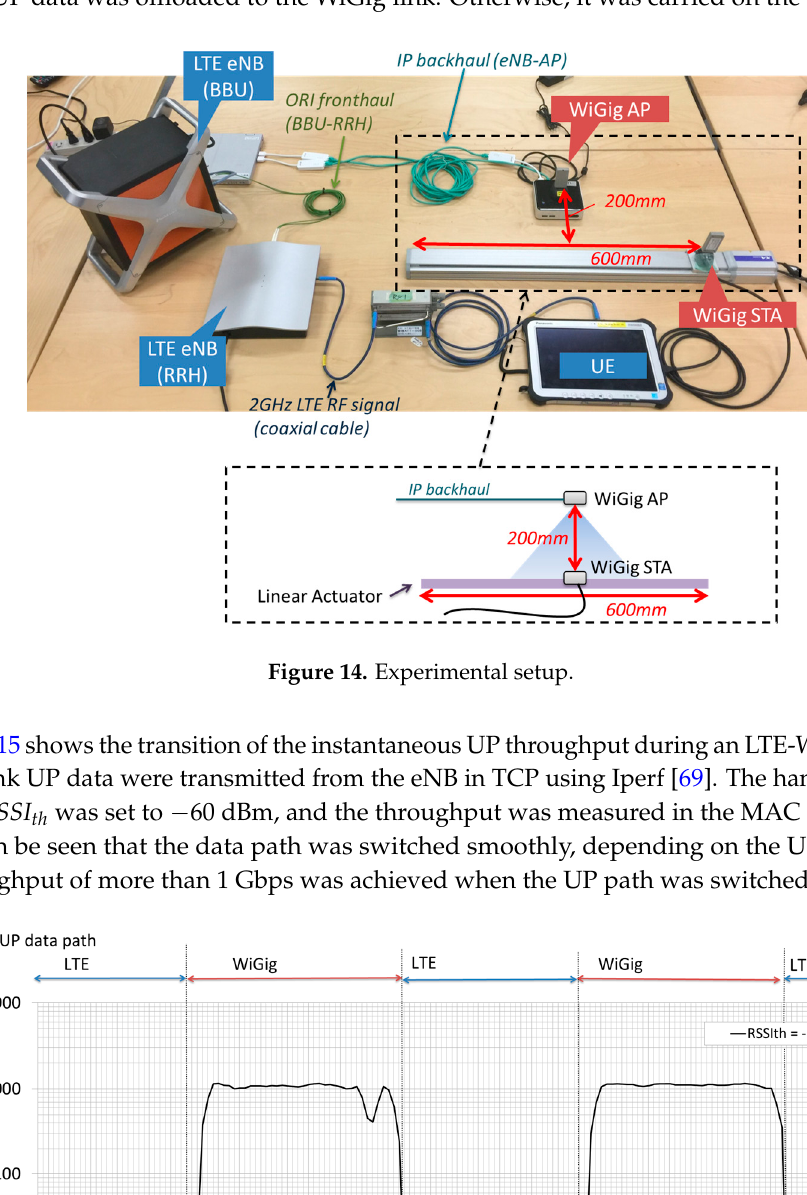
Figure 15. Transition of instantaneous UP throughput during LTE-WiGig handover.